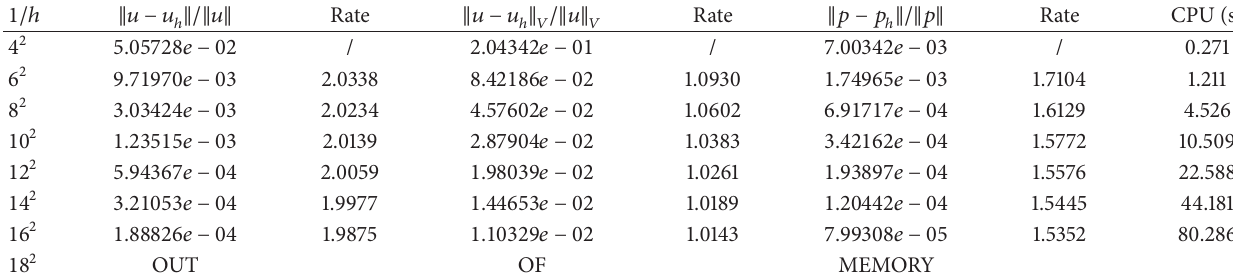
Table 1: Convergence of one-level method.